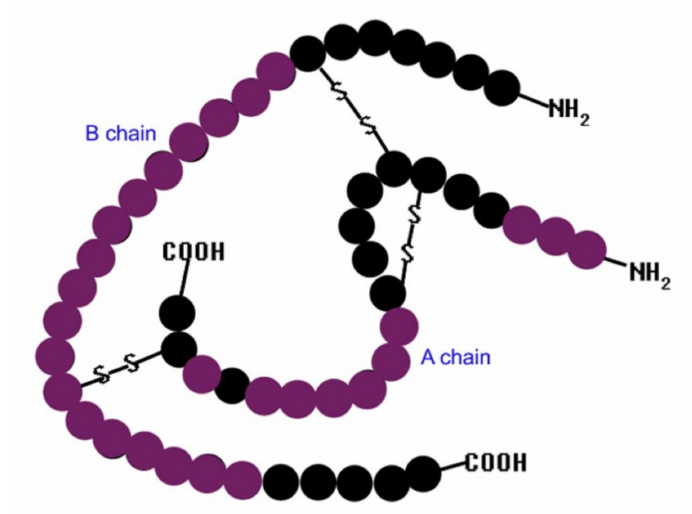
Figure 1. Insulin structure with the active parts of insulin in